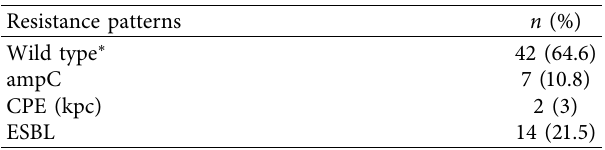
Figure 2: Pyogenic liver abscess organisms identifed in our study ∗ other pathogens: Pseudomonas aeruginosa , Klebsiella variicola , Haemophilus infuenza , Enterococcus sp ., Enterobacter sp ., Citrobacter koseri , Candida albicans . Table 3: Resistance patterns among Enterobacterales isolates from liver